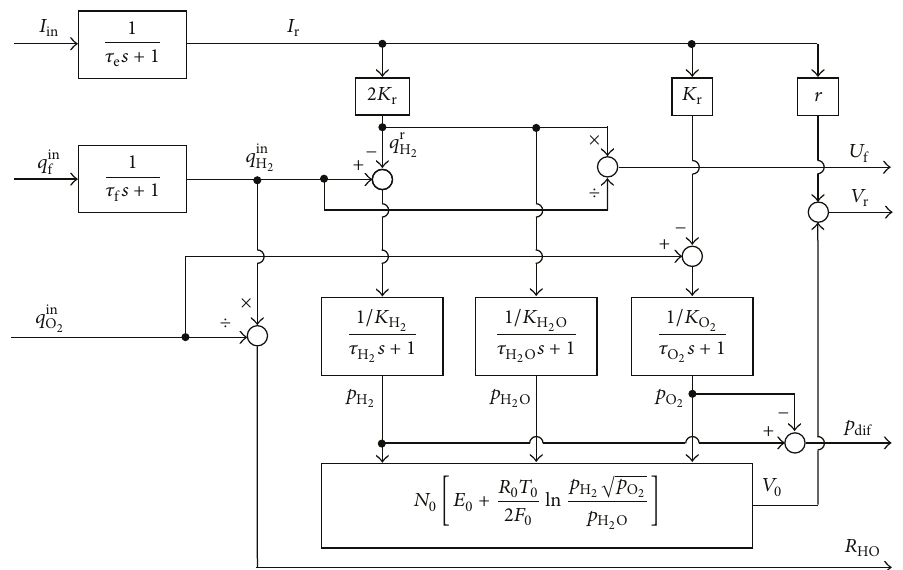
Figure 1: The structure of the fundamental continuous-time model of the SOFC